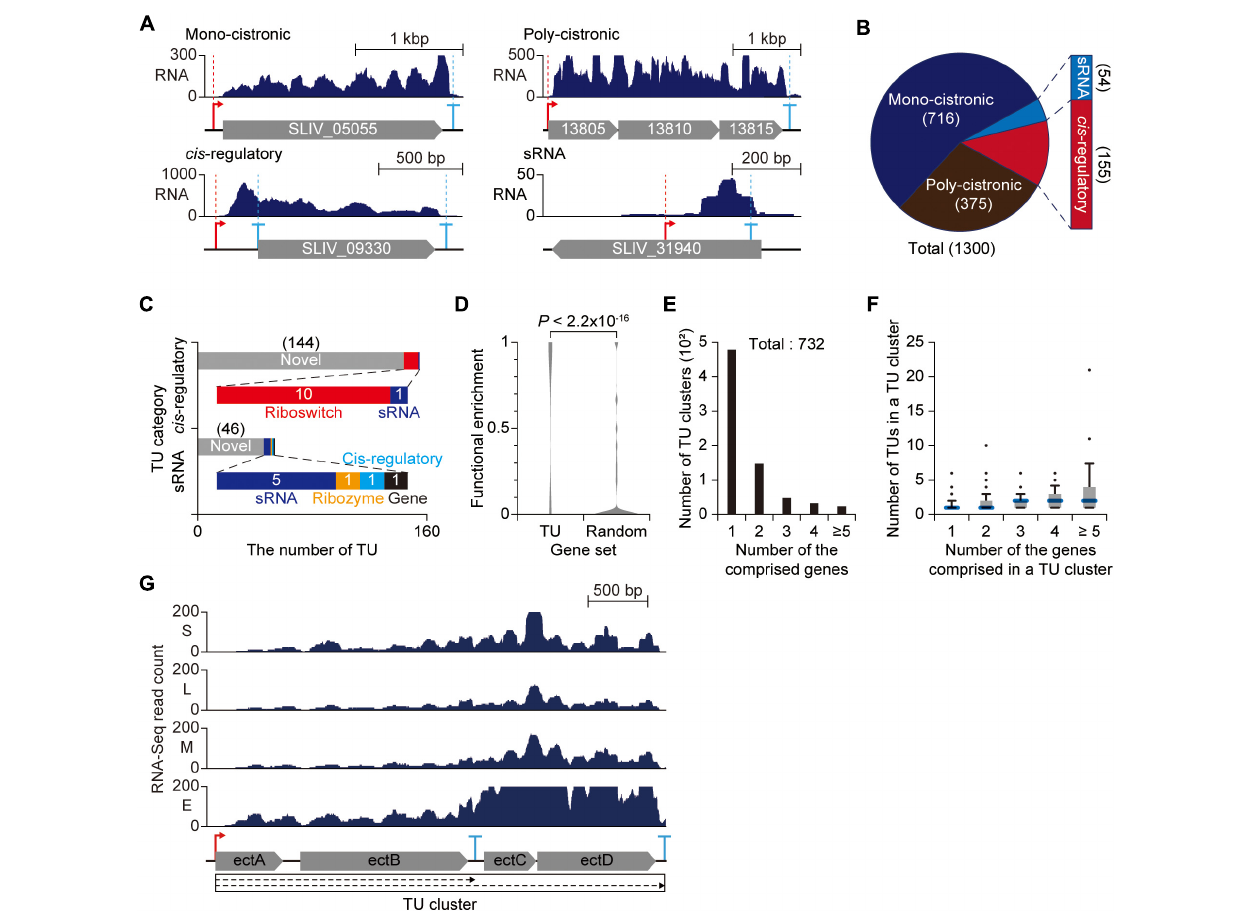
FIGURE 6 | Genome-wide determination of transcription units (TUs). (A) Example of each TU category. (B) The number of TUs determined from transcription start site (TSS) and transcript 3 (cid:48) -end position (TEP) information. (C) Characterization of non-coding TUs. sRNA and cis -regulatory TUs were searched against Rfam database. (D) The functional relatedness of genes in a same poly-cistronic TU. The functional enrichment was determined as the maximum frequency of genes with same COG functional category in a single poly-cistronic TU. (E) The number of TU clusters separated by the number of comprised genes. (F) Proportional relationship between the number of TUs in a TU cluster and the number of genes in the TU cluster. (G) The RNA-Seq profile of TU cluster for ectoine biosynthesis